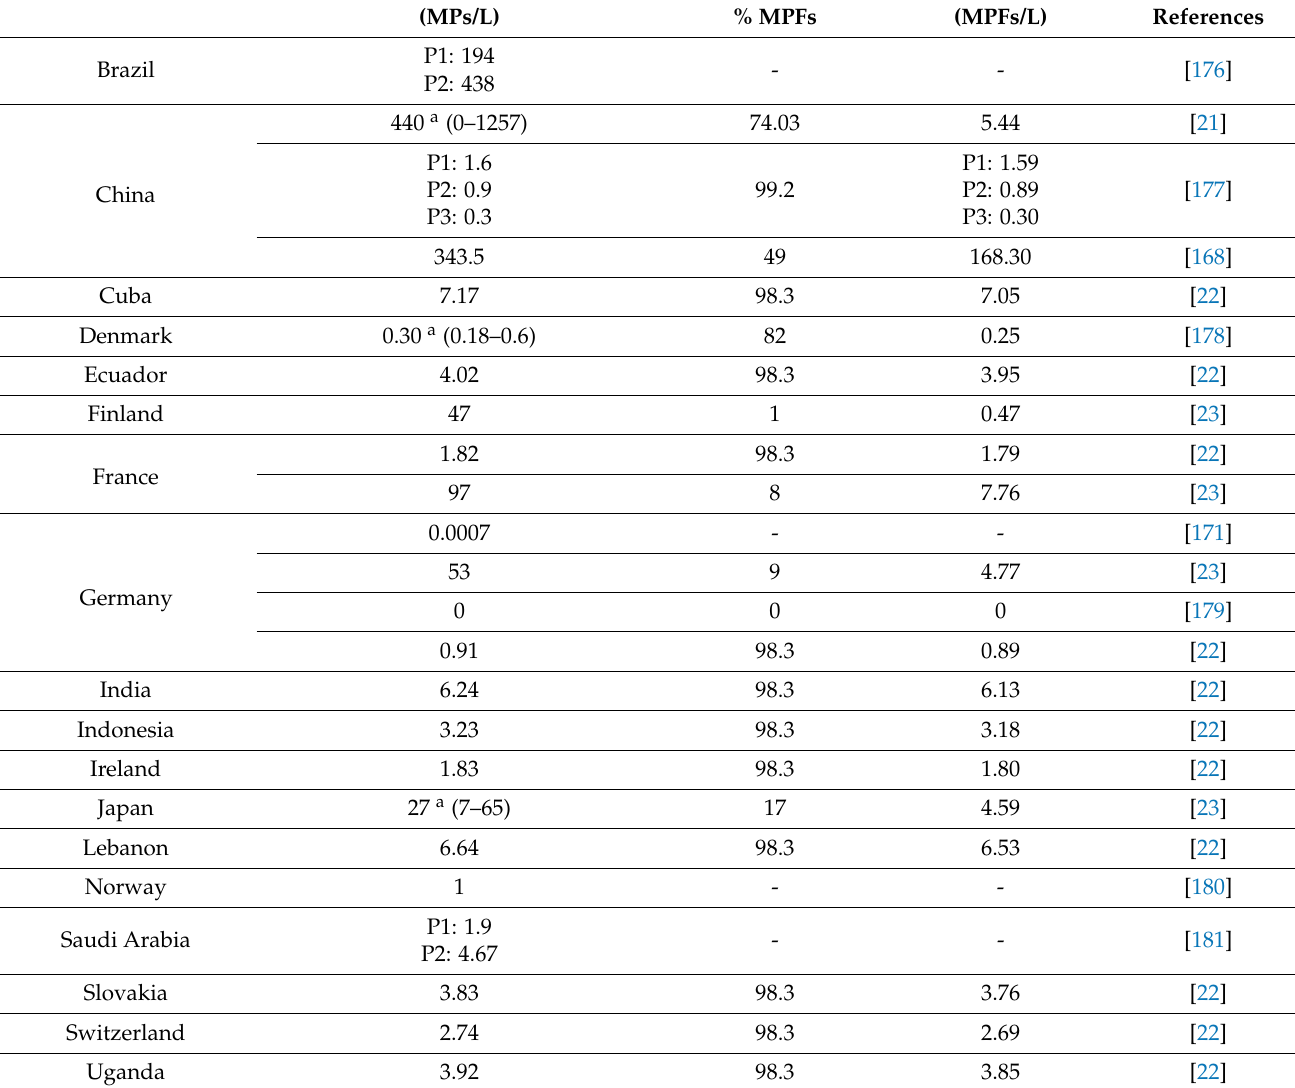
Table 4. Overview of the incidence of MPs and MPFs in drinking water. “P” followed by a number refers to samples of tap water taken at different points analysed in the cited